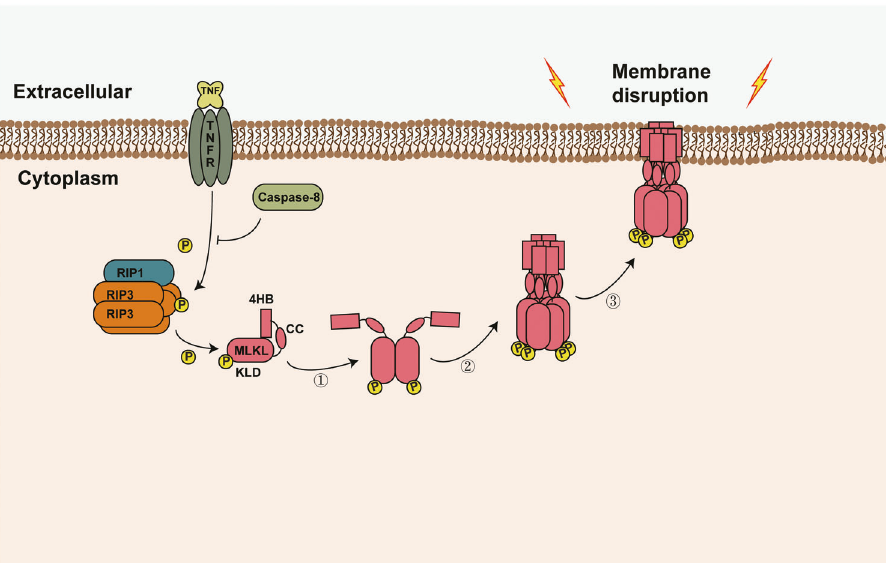
Fig. 5 Schematic model of MLKL mediated necroptosis execution. The serial activation steps of RIP3-phosphorylated MLKL during necroptosis execution are indicated: Step ① , phosphorylation by RIP3 induce MLKL kinase-like domain dimerization; Step ② , The self- interaction of kinase-like domain will initiate the self-assembly of the internal coiled-coil region, which causes MLKL oligomerization; Step ③ , oligomerized MLKL translocated to the plasma membrane to cause membrane